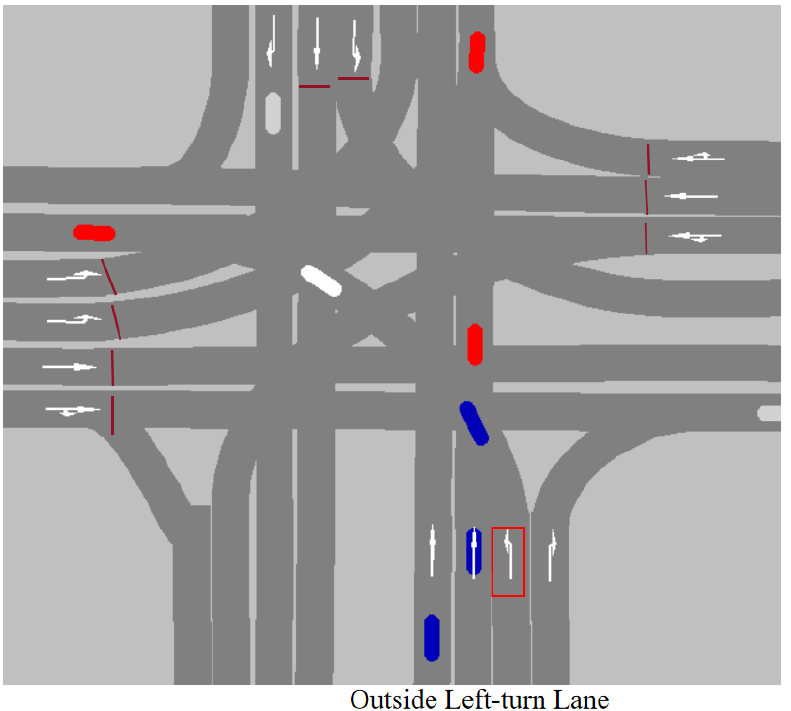
Figure 5. Simulation process.